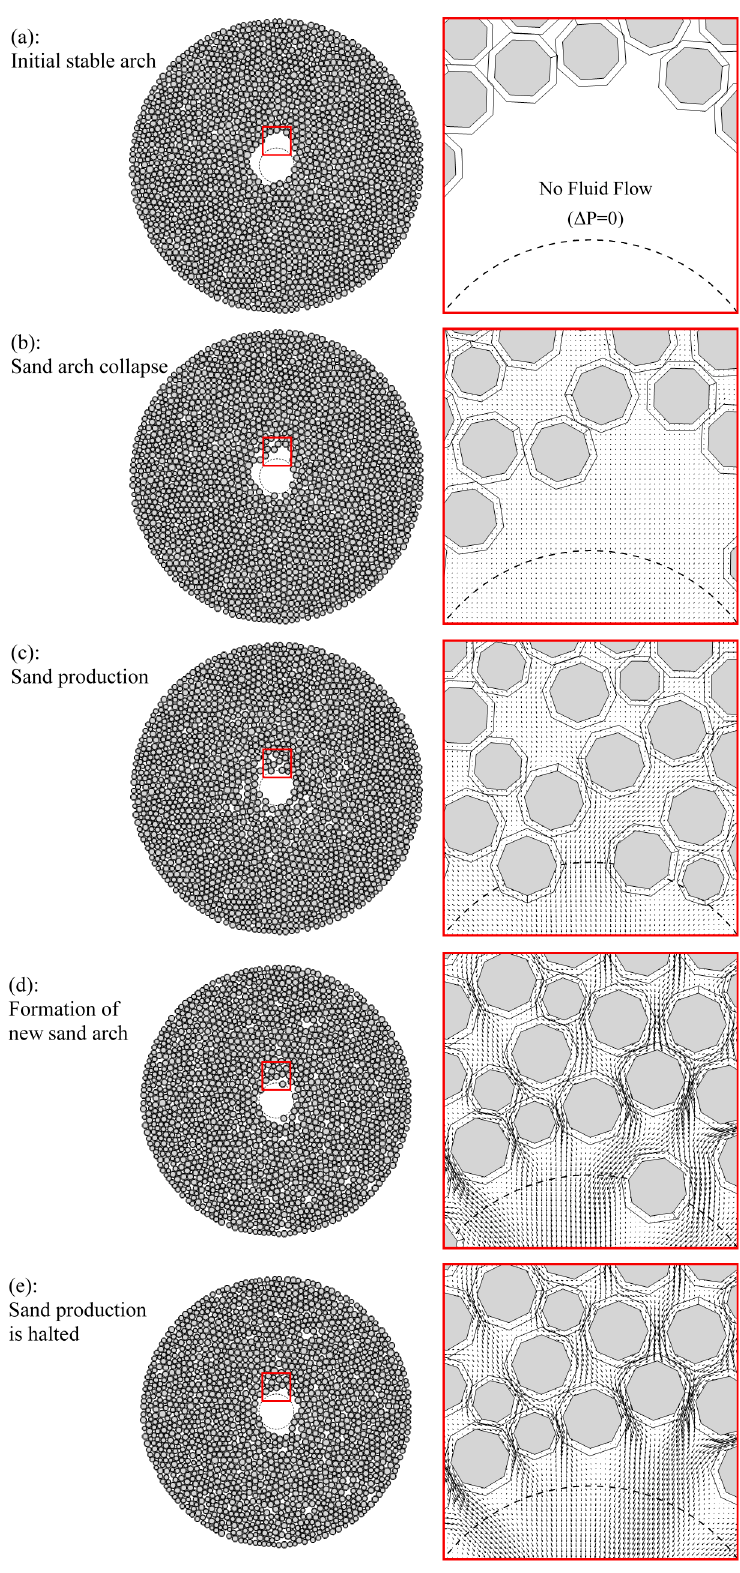
Figure 14. Snapshots of a closeup view of sand production process in UH15 model at different time-steps: ( a ) initial stable arch; ( b ) sand arch collapse; ( c ) sand production; ( d ) formation of new sand arch; ( e ) cessation of sand production. Vectors show fluid flow velocity direction and magnitude. Grey (filled) octagons represent virtual particles with hydraulic radii (as introduced in Section 2.3.1) and larger hollow octagons represent real particles with mechanical radii (actual dimensions).